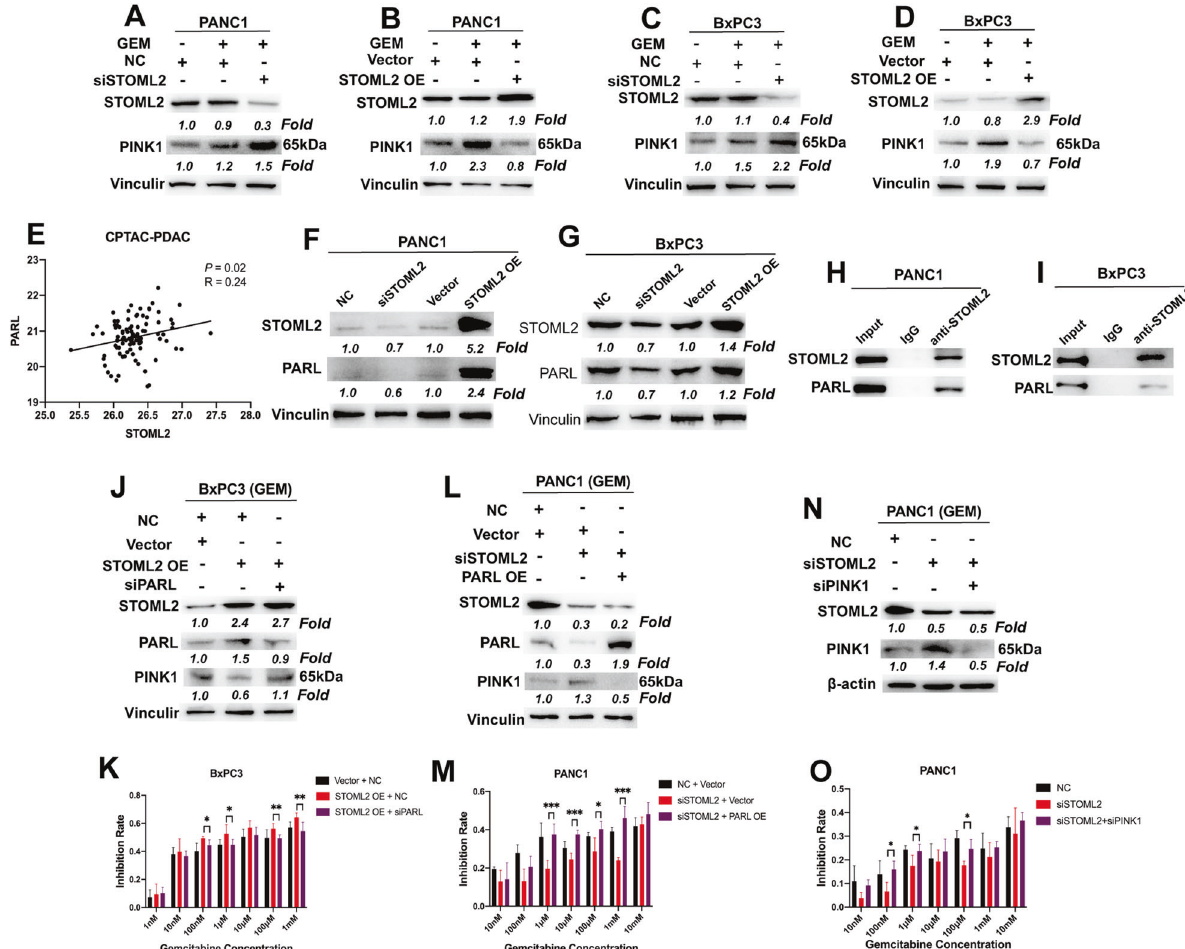
and BxPC3 cells after downregulating or upregulating STOML2. H , I Coimmunoprecipitation showed that STOML2 and PARL were pulled down by the STOML2 antibody in PANC1 and BxPC3 cells. J Immunoblot showing the protein levels of STOML2, PARL, PINK1 and Vinculin in